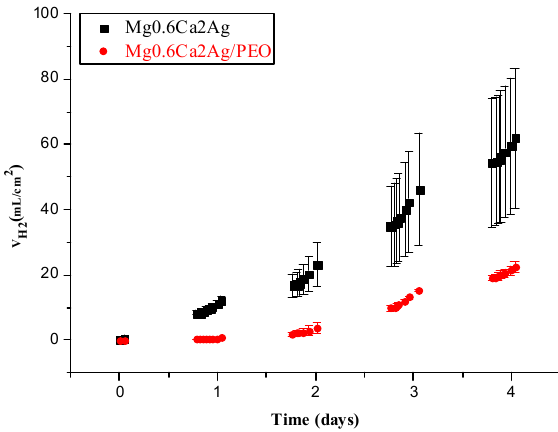
/ PEO after 4 days of immersion in m-SBF.